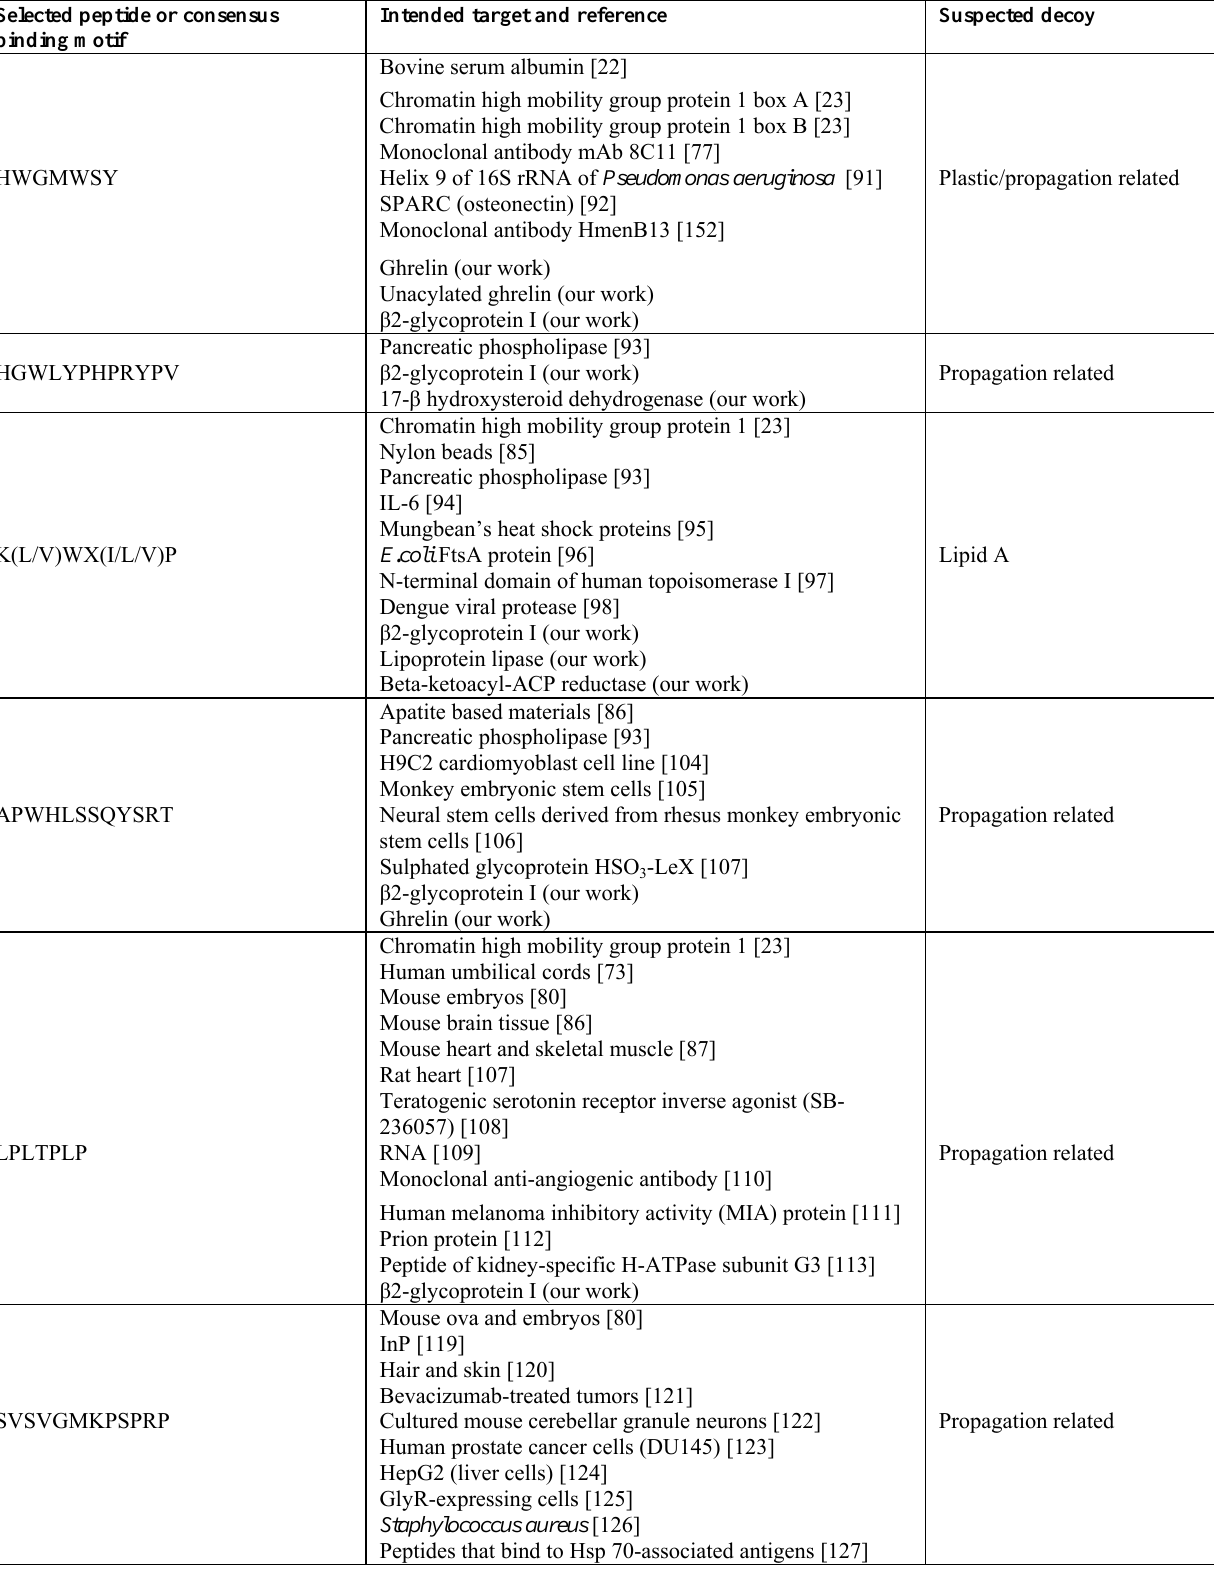
Table 3. Other frequently isolated peptides and